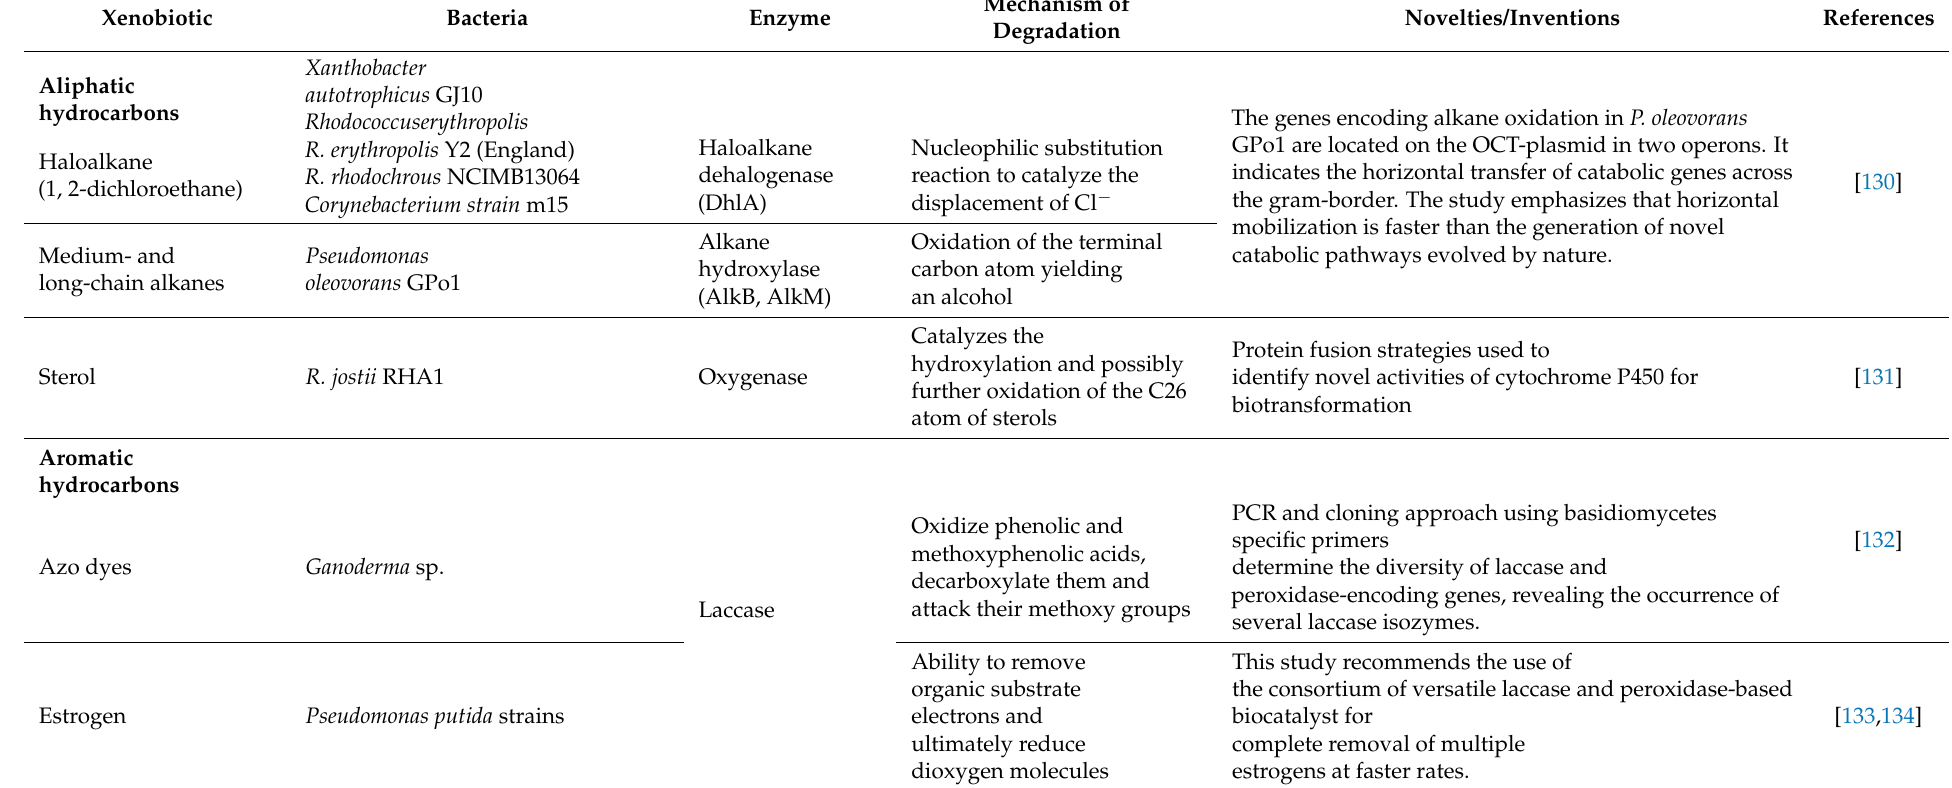
Table 3. Bacterial Enzymes involved in the transformation of various aliphatic and aromatic